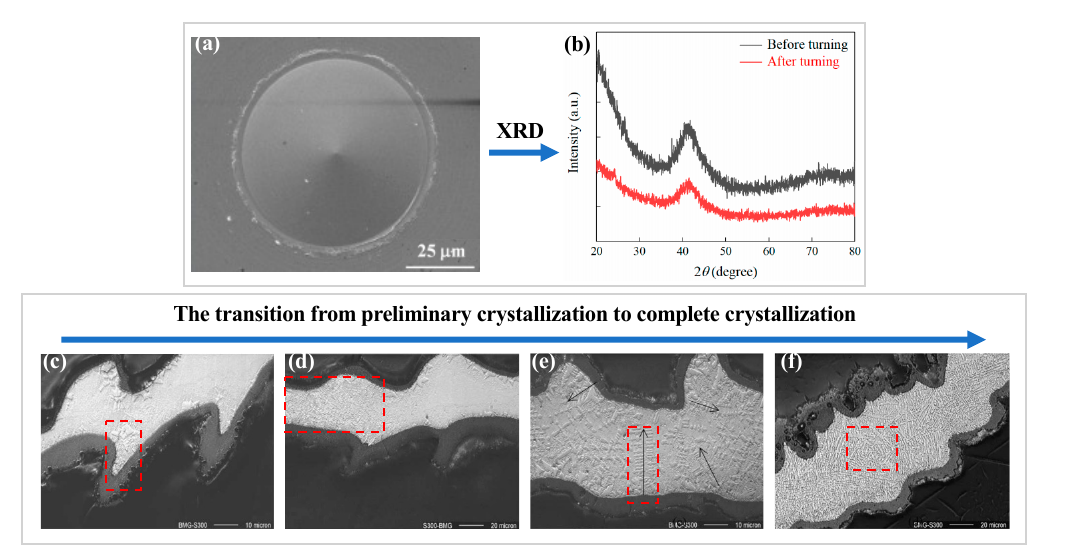
Figure 8. ( a ) The SEM image of the surface of BMG after SPDT. ( b ) XRD pattern of BMG before and after machining, no crystallization was shown [78]. ( c ) Initial crystallization near the oxide layer. ( d ) Region of no crystallization on the right and crystallization on the left. ( e ) Increasing dendritic pattern with increased crystallization. ( f ) Region of complete crystallization of BMG, adapted with permission from Ref. [80] 2004, Elsevier. The red mark is the crystalline region.